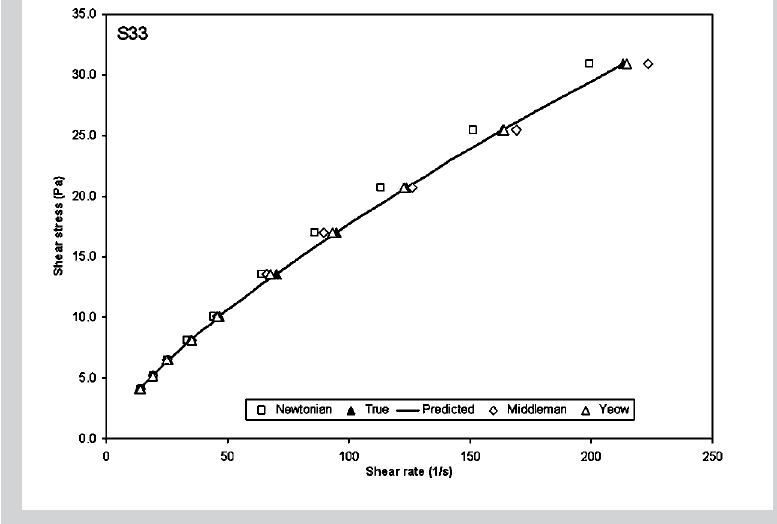
Figure 9: Comparison of shear rate versus shear stress for a 1% CMC solution as given by Yeow [19], Middleman [39] and the proposed method- ology. The Newtonian equa- tion (Newtonian) is also shown. The predicted values by the new approach ('pre- diction') are also shown as the solid line (r = 1.54 cm, 1 r = 1.94 cm, d = 2